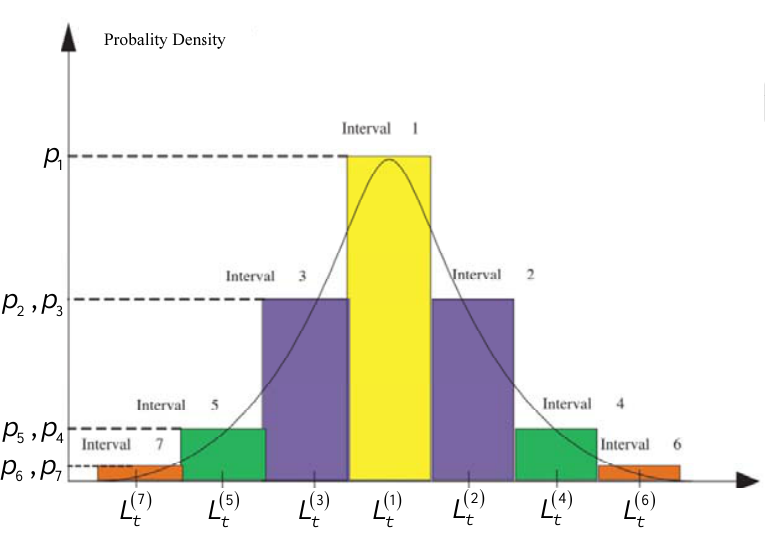
Figure 3. Discretization method of load demand distribution function.